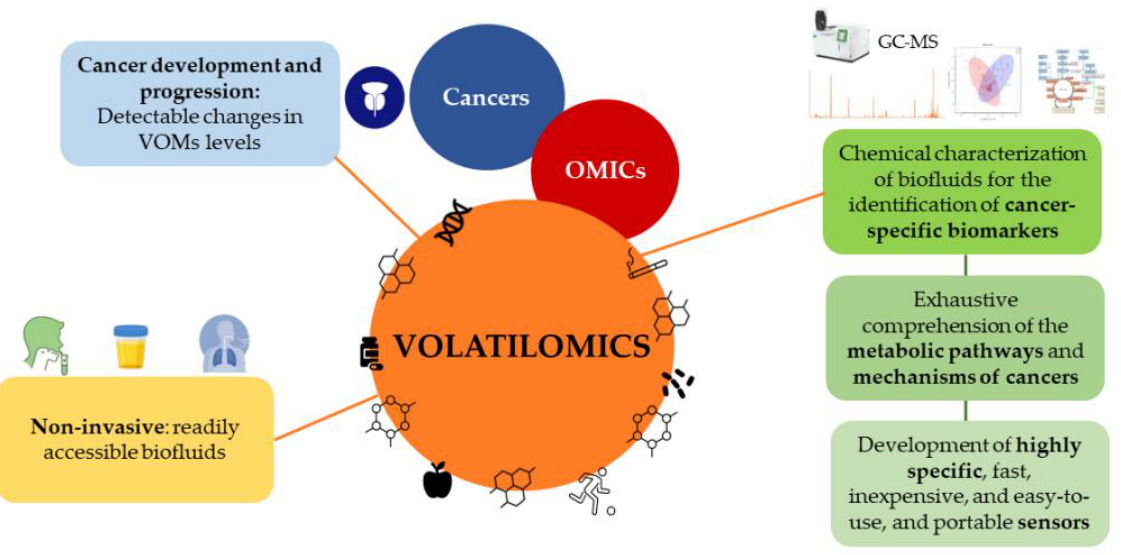
Figure 5. Cancer development and progression can lead to changes in the levels of volatile organic metabolites, which can be used to define a volatilomic biosignature for diagnostic